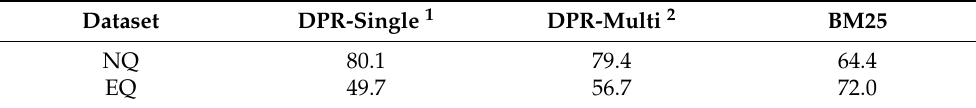
Table 1. Retrieval results (Top-k) on NQ and EQ